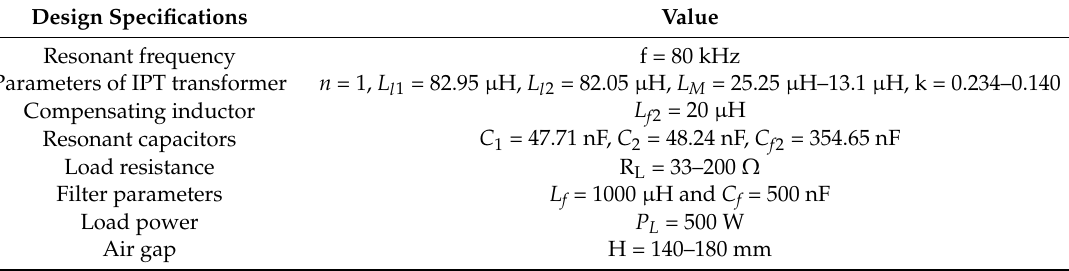
Table 1. Design specifications of the LC-LC2 converter.